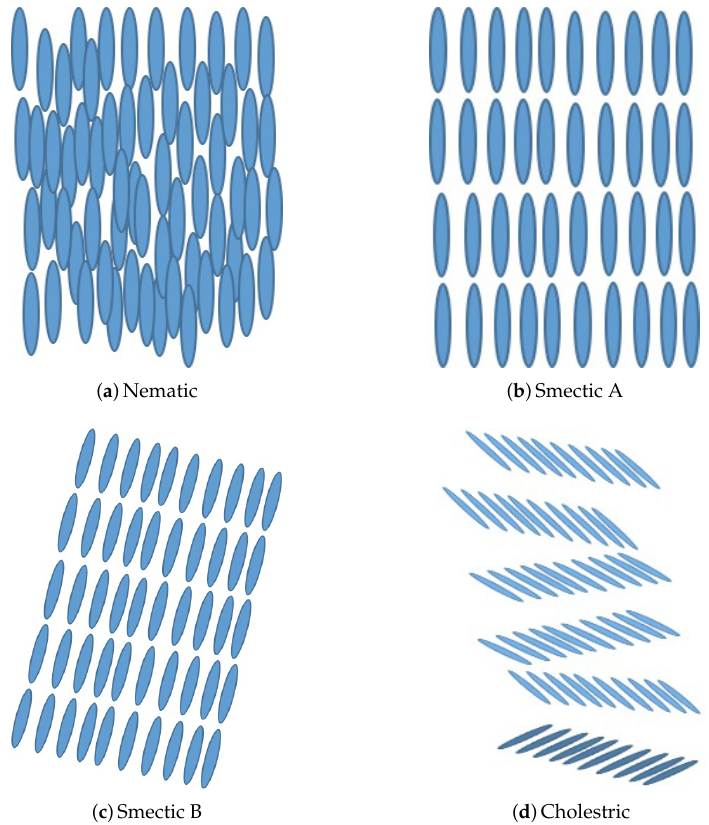
Figure 9. Phases of liquid crystals. ( a ) Nematic phase. ( b ) Smectic A phase. ( c ) Smectic B phase. ( d ) Cholestric